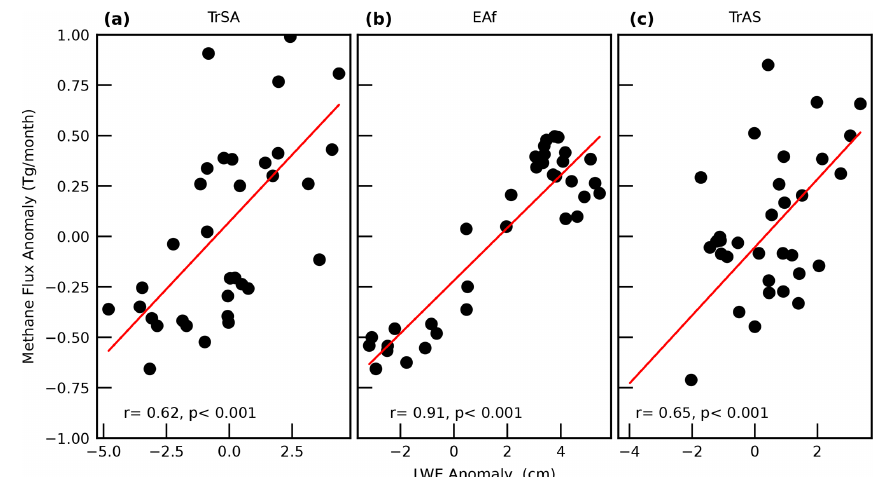
Figure 4. Scatter plot of monthly GRACE-FP LWE anomalies (cm) and methane flux anomalies, 2018–2021, over (a) tropical South America, (b) Eastern Africa, and (c) tropical Asia. Red lines denote the linear regression. Numbers atop of each panel denote the Pearson correlation coefficient r and the p value.